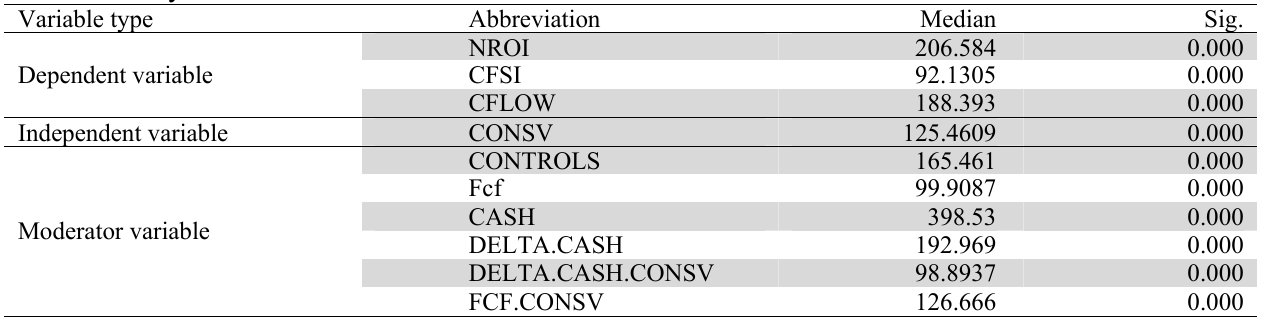
The summary of ADF test